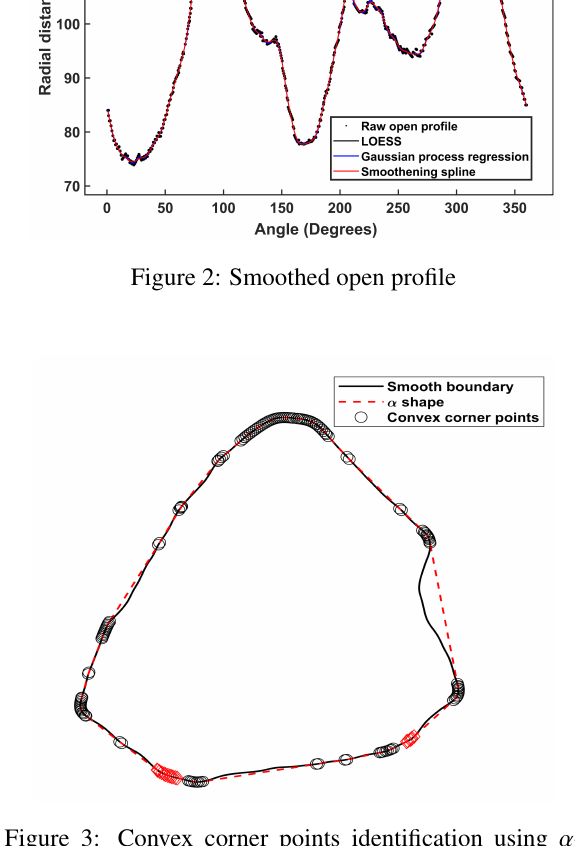
Figure 3: Convex corner points identification using α - shape